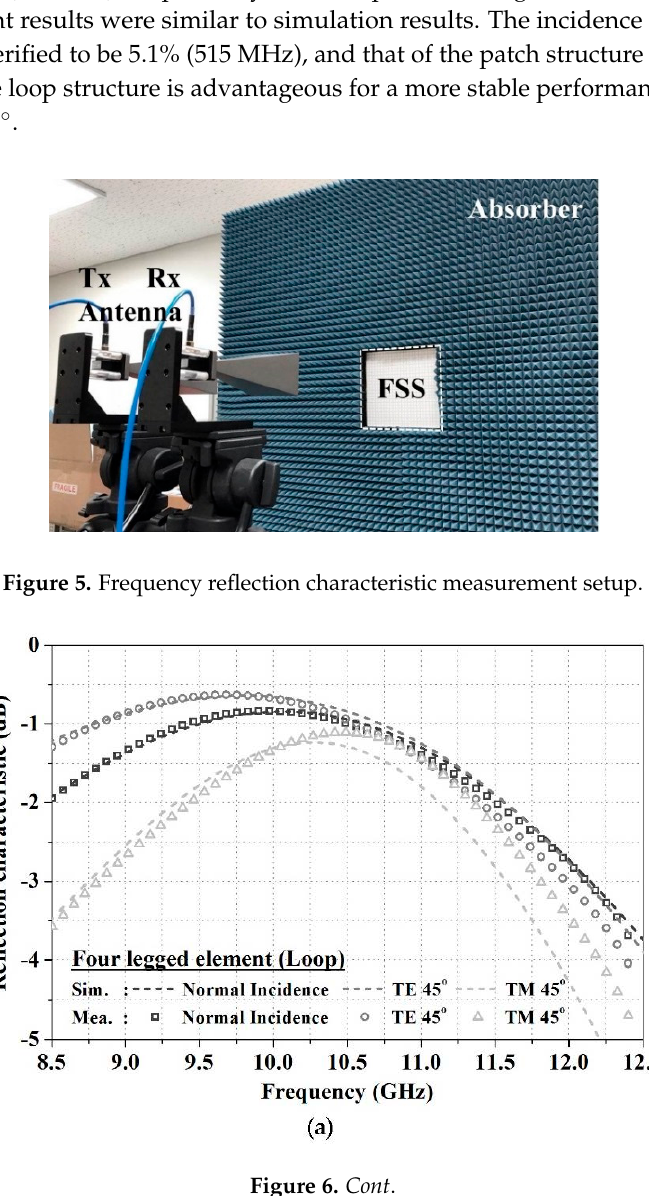
Figure 6. Measurement results of frequency reflection characteristic: ( a ) Loop type; ( b ) Patch type. 3.2. Measurement of the Security Paper Using a Detector To create a system in which an alarm sounds when the security paper passes through an antenna gate, a detection system with a detector module equipped with a patch antenna and an LED was created, as shown in Figure 7, and its FSS detection area was observed. As shown in Figure 7, the detection system is composed of a transceiving patch antenna, detector module, network analyzer, signal generator, power supply, and multimeter. The transmitting antenna receives signals from the signal generator and sends them to the FSS. Then, the receiving antenna receives the reflected signals from the FSS and verifies the detection area through the LED lights of the detector module. The signal generator applies a signal strength of − 10 dBm to the transmitting antenna, and the detector module receives power of 158 mA from the power supply at 6 V, and a power of 150 mA from the LED at 5 V. To clearly observe the LED lights, a multimeter was connected to the LED terminal to verify the output of 5 V. To verify the detection area according to the distance of the security paper and to prevent leakage of folded paper with the detector module system, the detection area was observed according to the number of times the paper was folded. The security paper was folded in half five times for the test. The paper size and number of unit structures in relation to the number of folds are tabulated in Table 1. After the detection area was measured by using the detector module, the received signal strength indicators (RSSI) were observed. The measurement results are shown in Figure 8. The loop structure was detectable at